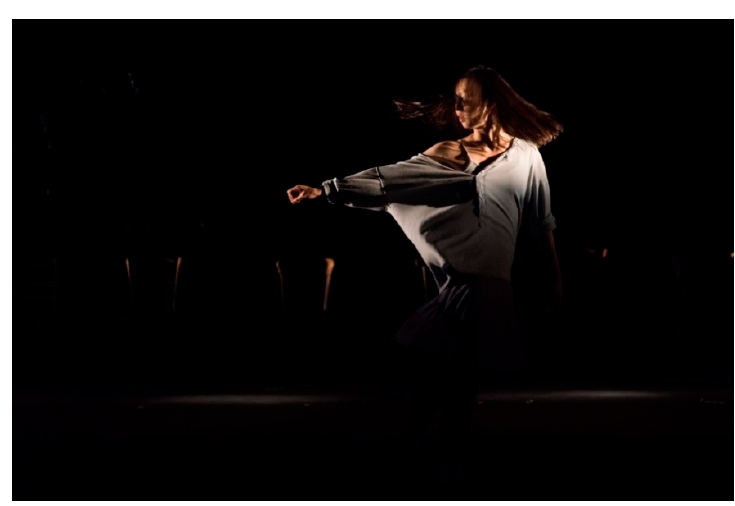
Figure 6. Rosas danst Rosas (2017) Anne Teresa De Keersmaeker / Rosas © Anne van Aerschot. Used with permission.